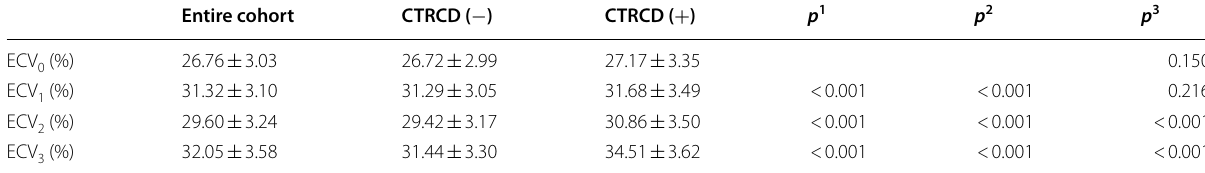
) and group CTRCD ( ) at different time points − +